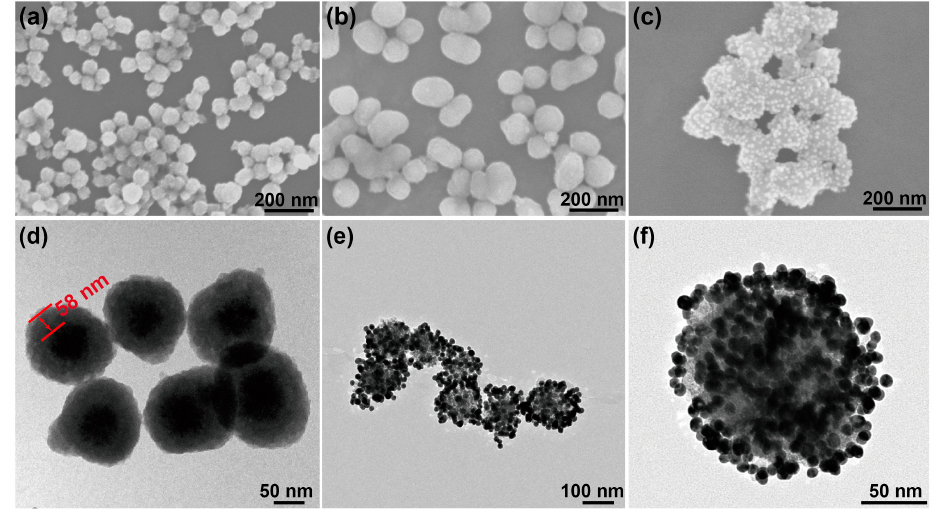
Figure 1. SEM images of ( a ) Fe 3 O 4 ; ( b ) Fe 3 O 4 @TiO 2 ; and ( c ) Fe 3 O 4 @TiO 2 @Au nanocomposites. TEM images of ( d ) Fe 3 O 4 @TiO 2 and ( e , f ) Fe 3 O 4 @TiO 2 @Au nanocomposites.